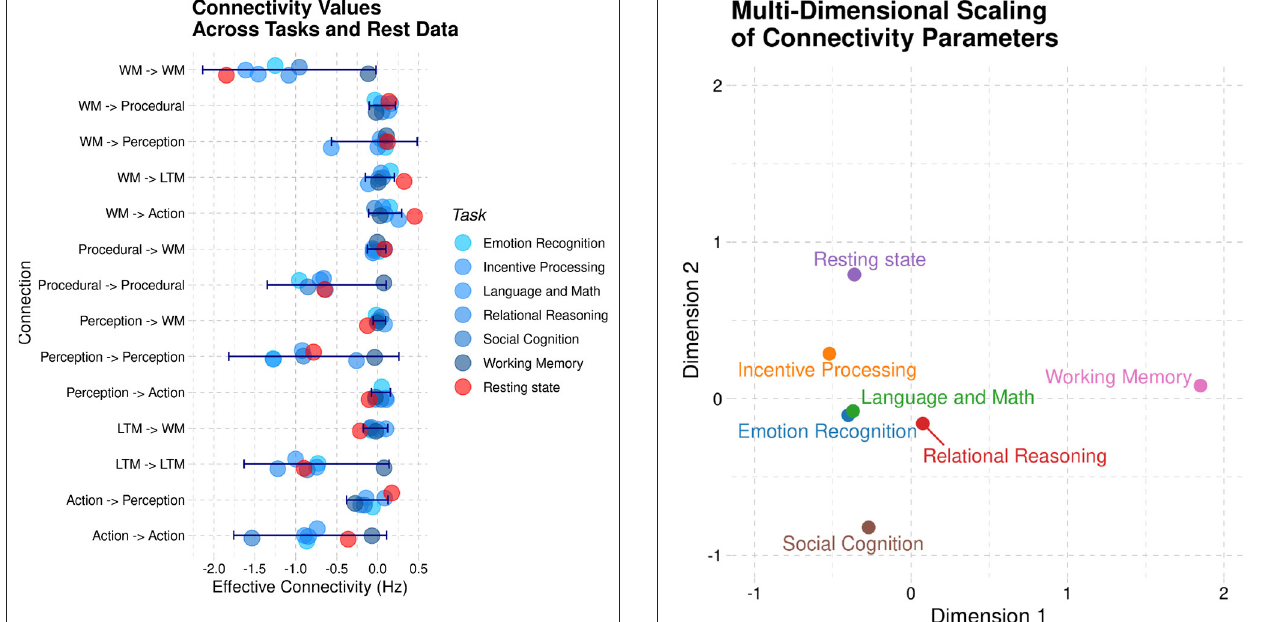
FIGURE 12 | Multi-dimensional scaling of the correlations between effective connectivity parameters across all recording paradigms (six task-based and one resting-state). Note that Resting state does not significant stand apart from the task-based data, being, in fact, closer to the other tasks than the working memory